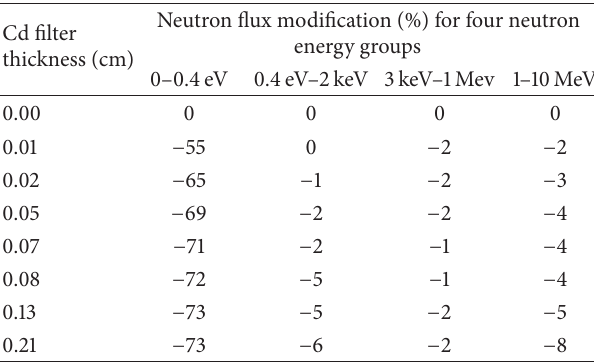
Table 1: Effect of Cd filter thickness on the neutron flux [6]. Cd filter thickness